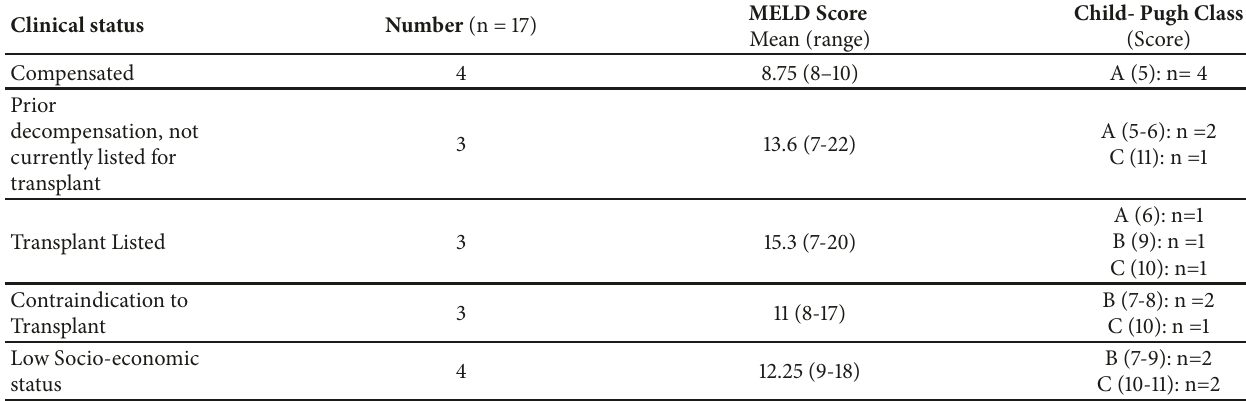
Table 3: Participants’ clinical